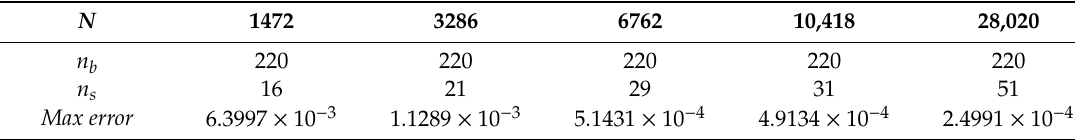
Figure 6. The distribution of numerical solution in Case 2. Table 2. The maximum absolute error for Case 2.